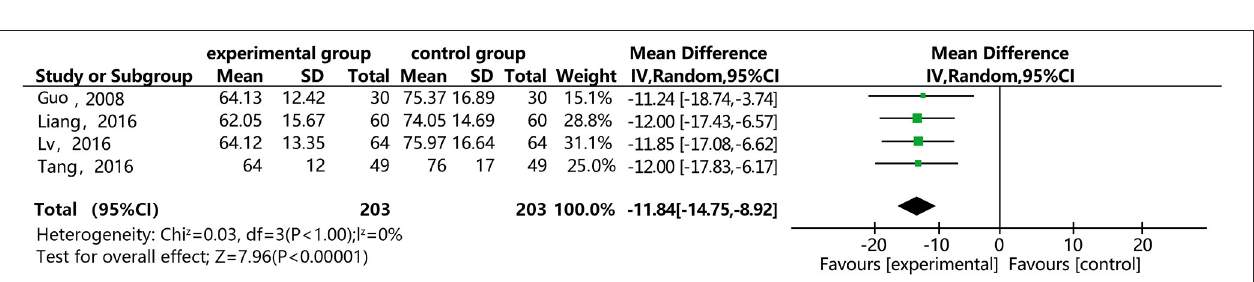
FIGURE 12 | Meta-analysis forest map of the effect of DSP combined with aspirin on PAMG in patients with CHD.